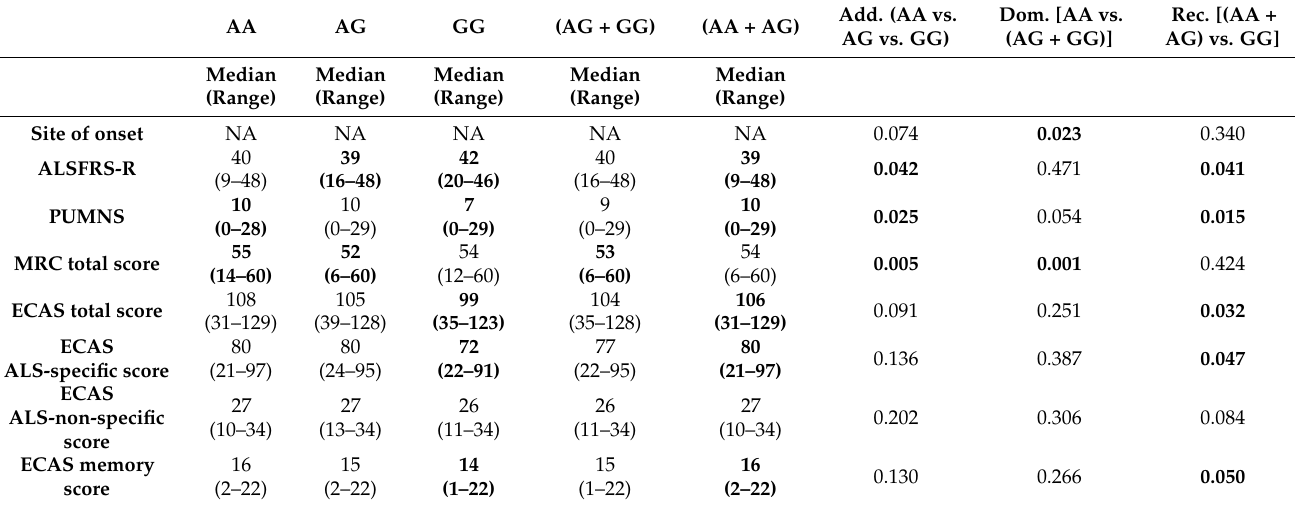
Table 2. Comparison of the site of onset, ALSFRS-R, PUMNS, MRC total score and ECAS